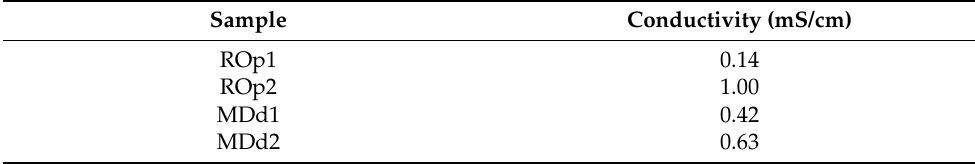
Figure 3. OMW conductivity against the volume concentration ratio achieved at each treatment step. To assess the efficacy of RO and VMD processes to retain the dissolved inorganic electrolytes, two samples of permeate water were collected at the middle (ROp1 sample, Figure 2) and at the end (ROp2 sample, Figure 2) of the RO concentration process. Simi- larly, the initial and final distillate samples (MDd1 and MDd2, Figure 2) from the VMD concentration step were considered. The conductivity values of these samples (Table 1) confirmed that both methods reduced the electrolyte content in the fraction by about 98.5%. Table 1. Conductivity of ROp and MDd samples.